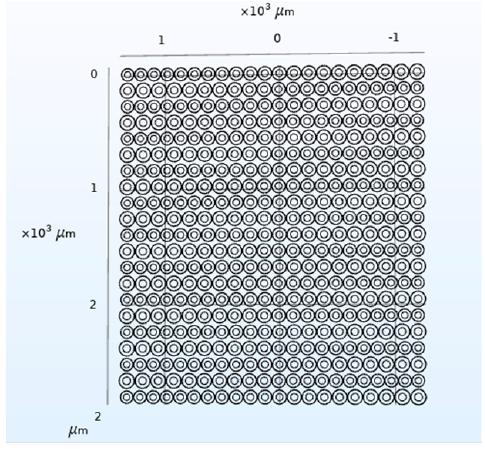
Figure 18. CMUT structure ( w = 80%).